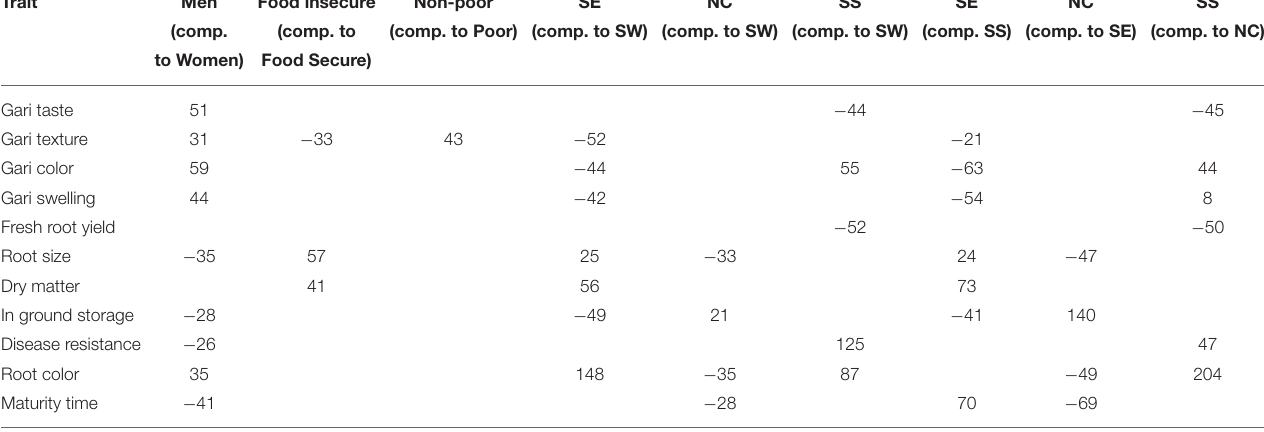
TABLE 3 | More (+) or less ( − ) odds (%) of ranking a trait low comparing the social binary categories of men/women, Food Insecure/Food Secure and Non-poor/Poor [based on the Poverty Probability Index (PPI) and Household Food Insecurity Access Scale (HFIAS)].